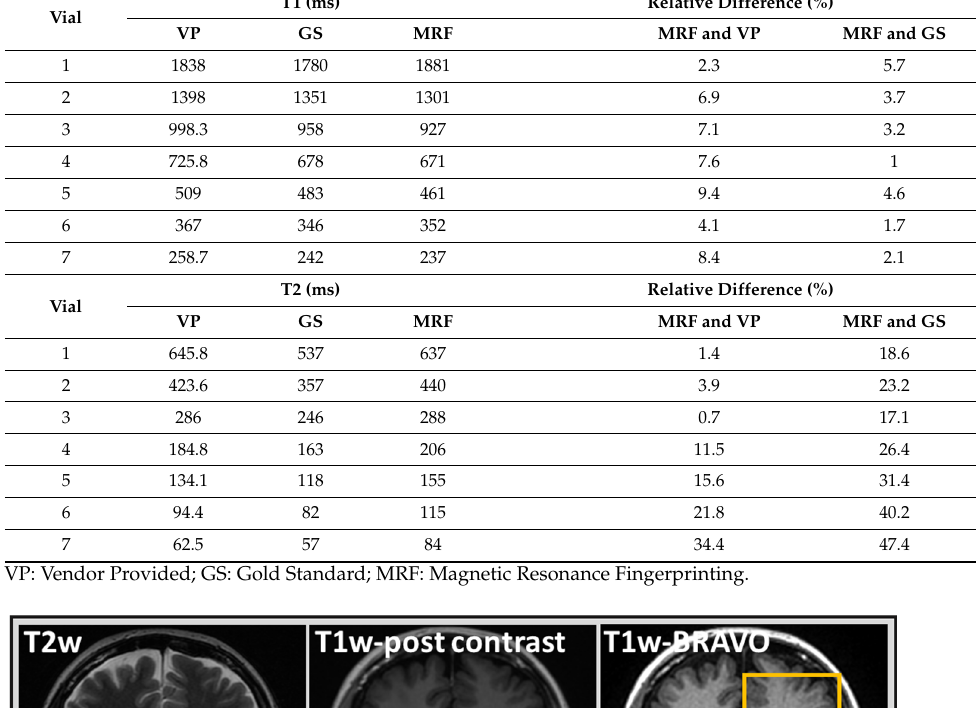
Table 2. Estimated T1 and T2 values from three different methods using MRI system phantom. Vial